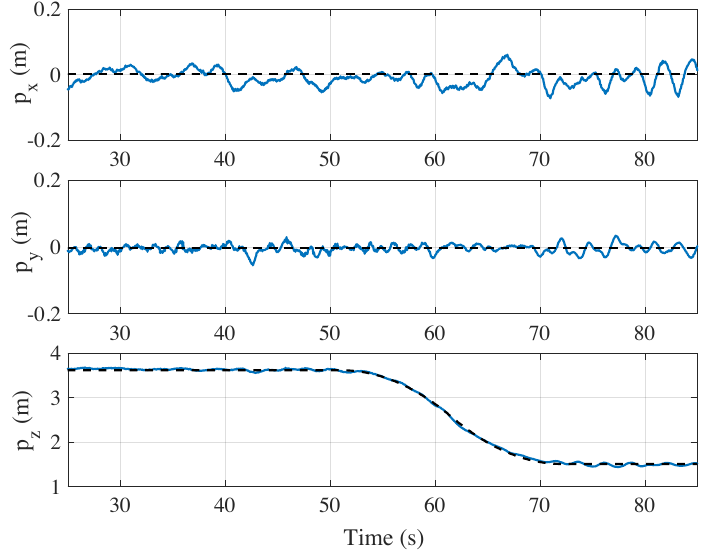
Figure 16. Drone position vs time: the blue solid curves represent the 3D-position of the drone in an experimental test with a desired straight trajectory having a triangular velocity profile (black dashed lines) starting at t = 50 s. The estimated positions of the drone are obtained on-board applying the implemented SCF-MF-3DOF algorithm to the data from the IMU and the camera during the